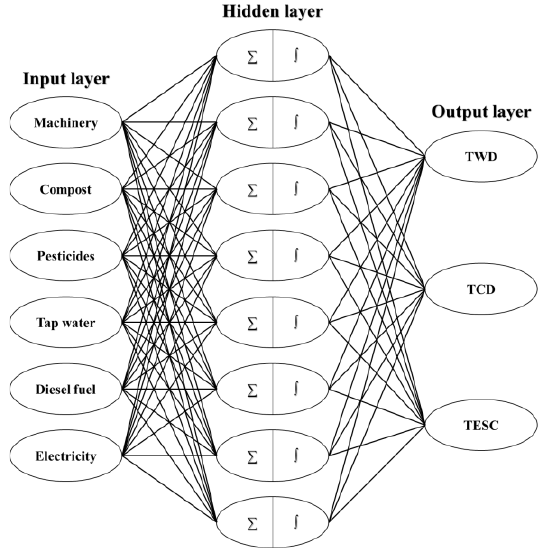
Figure 7. Schematic diagram of the best structure of ANN model.